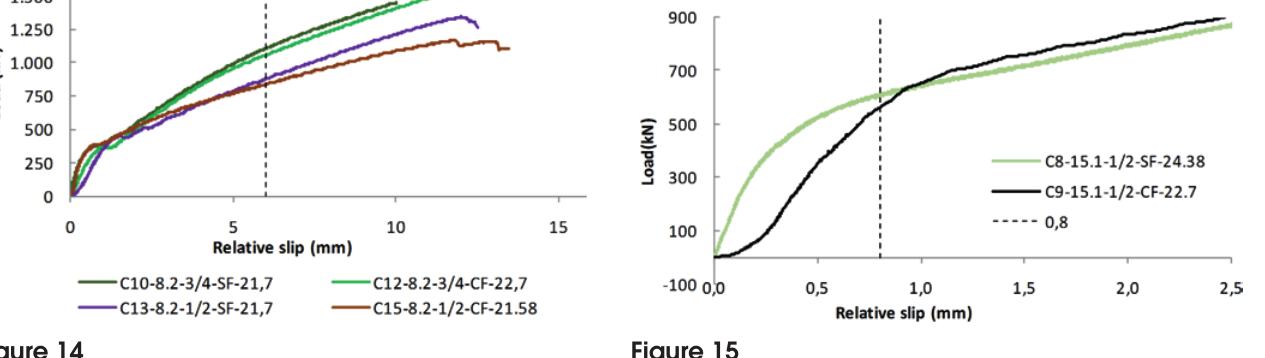
Curves load versus displacement relative for the tests with tubular section 219x8,2 mm e fck de 20 MPa